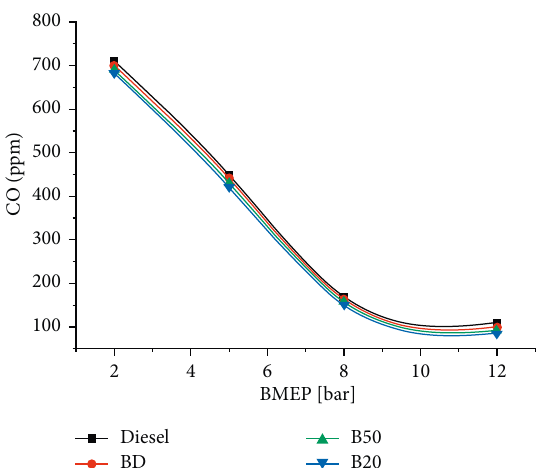
Figure 6: CO emission with bmep @ 2000rpm.